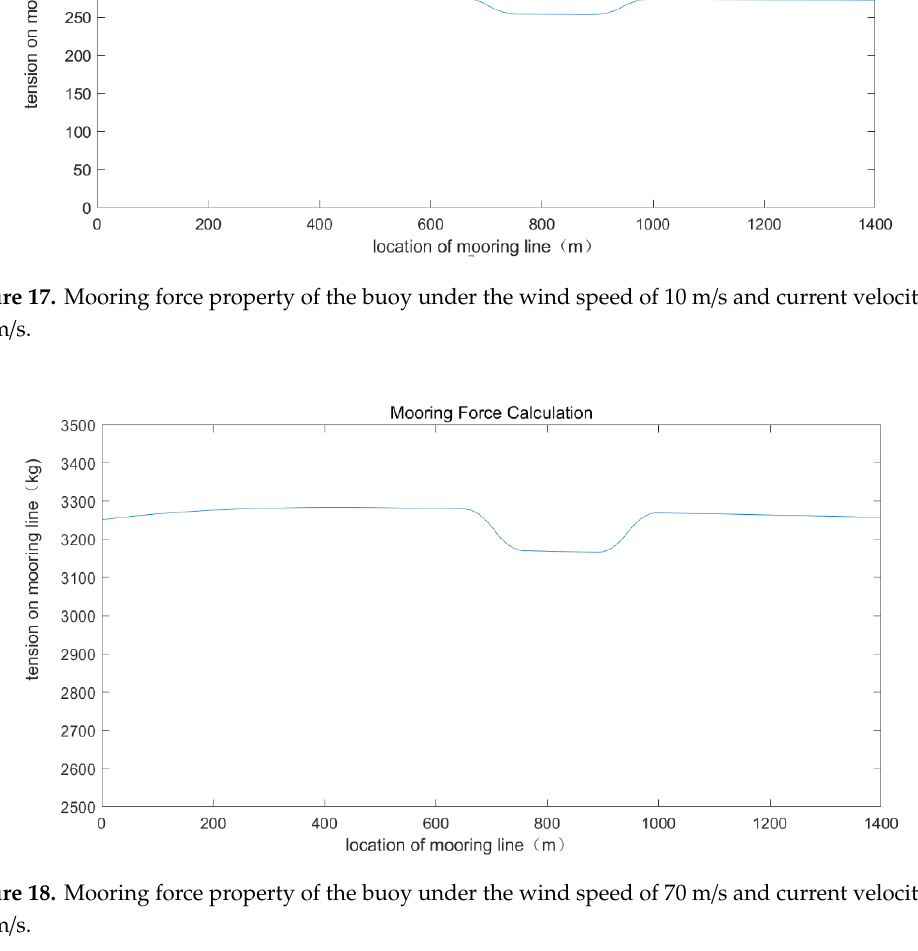
of 3.0 m/s. 3.0 m /